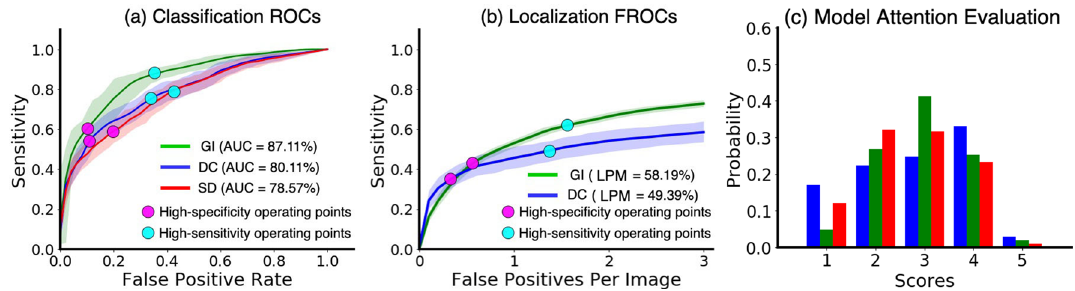
Figure 2. Quantitative analysis of the results of our model. ( a ) Receiver operating characteristic curves for predicting the existence of conditions. ( b ) Free-Response receiver operating characteristic curves for localizing conditions. ( c ) Distribution of dentists’ ratings on the localization for soft deposits. Gingivitis, dental calculus, and soft deposits are represented as GI, DC, and SD,